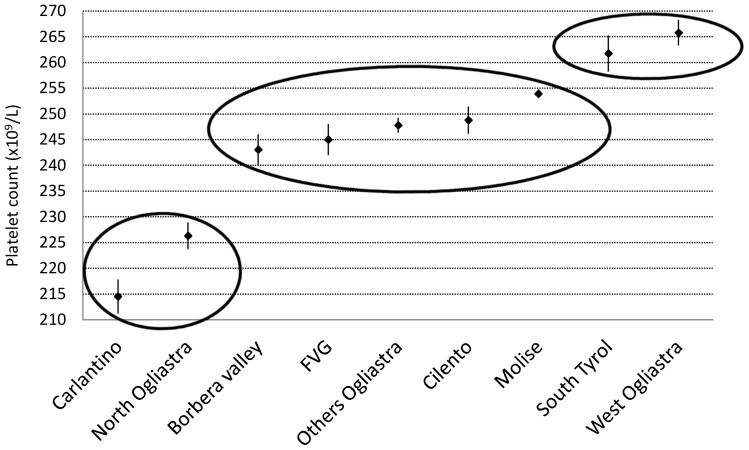
Mean platelet count in the nine sub-populations along with 95% CI.Estimates have been obtained by ANOVA adjusting for age and sex. Three strata may be obtained grouping sub-populations according to their mean platelet counts, as evidenced by black circles: Low (Carlantino and North Ogliastra), Medium (Borbera valley, FVG, Others Ogliastra, Cilento and, Molise) and, High (South Tyrol and West Ogliastra).